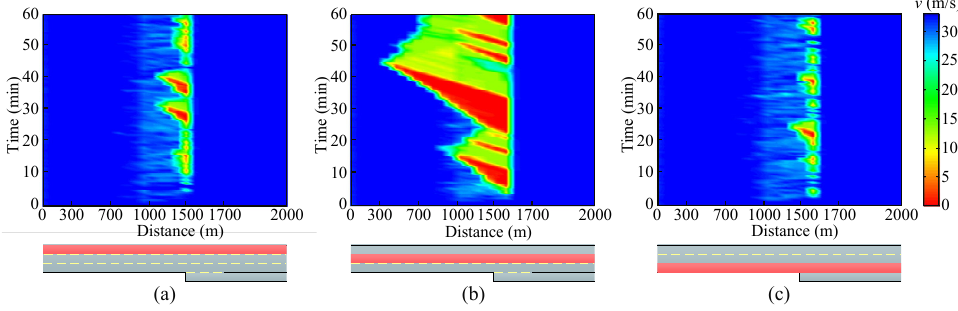
Figure 7. Characteristics of average speed in different lanes. ( a ), ( b ) and ( c ) respectively the median, center and shoulder lanes.